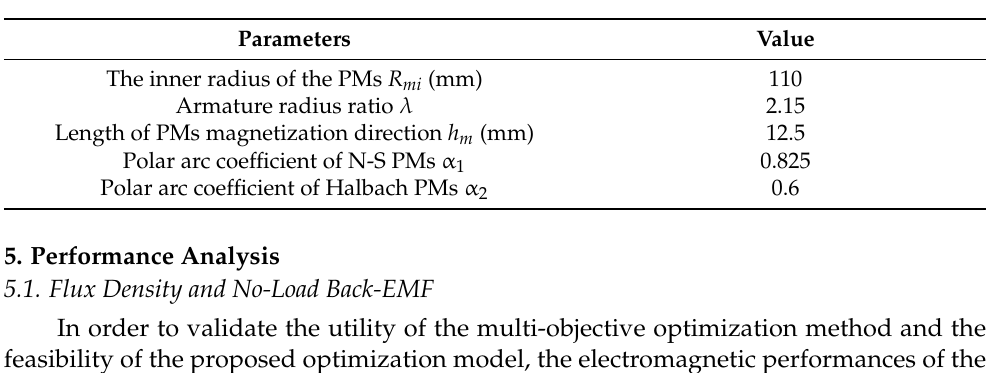
Figure 5. The results of multi-objective optimization for the SCM-AFPM motor. ( a ) the optimization results of the SCM-AFPM motor and ( b ) the optimal motor topologies of the SCM-AFPM motor. Table 2. The optimized design parameters of the SCM-AFPM motor.